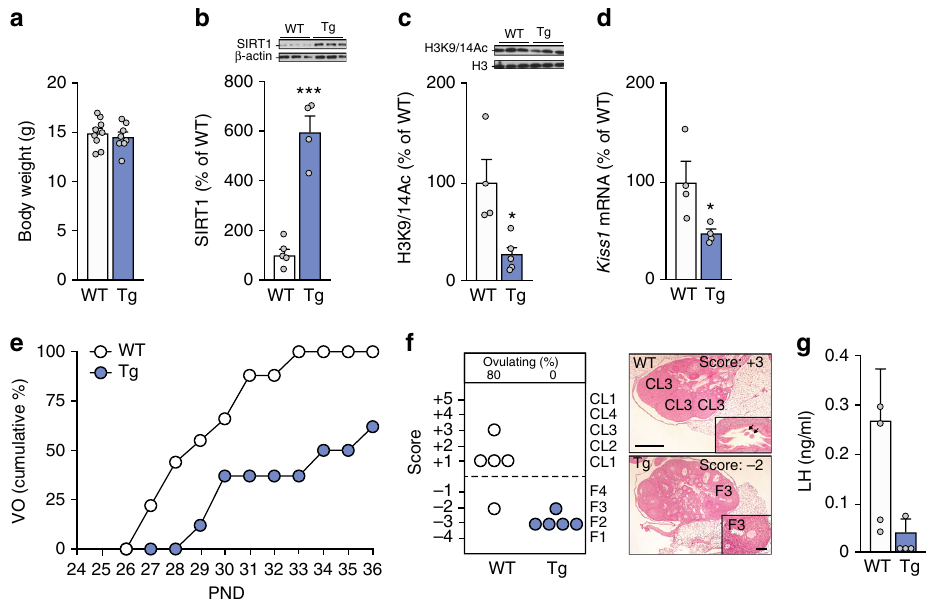
Fig. 3 Transgenic SIRT1 excess in female mice delays pubertal timing. SIRT1 content and indices of somatic/pubertal maturation in a transgenic model of moderate Sirt1 overexpression (Tg; cyan bars) and wild-type (WT; white bars) controls measured at PND32 are shown. a Body weight. b Hypothalamic SIRT1 content. c Hypothalamic H3K9/14Ac content. d Hypothalamic Kiss1 mRNA levels. e Cumulative percent of animals showing vaginal opening (VO). f Histological score of follicular development/ovulation and representative images of ovarian maturation; CL: corpus luteum, F3: stage-3 follicle; released oocytes are denoted by arrows in the inset. g Plasma LH levels. The bar histograms represent the mean ± SEM. * p < 0.05; *** p < 0.001 (two-sided Student ’ s